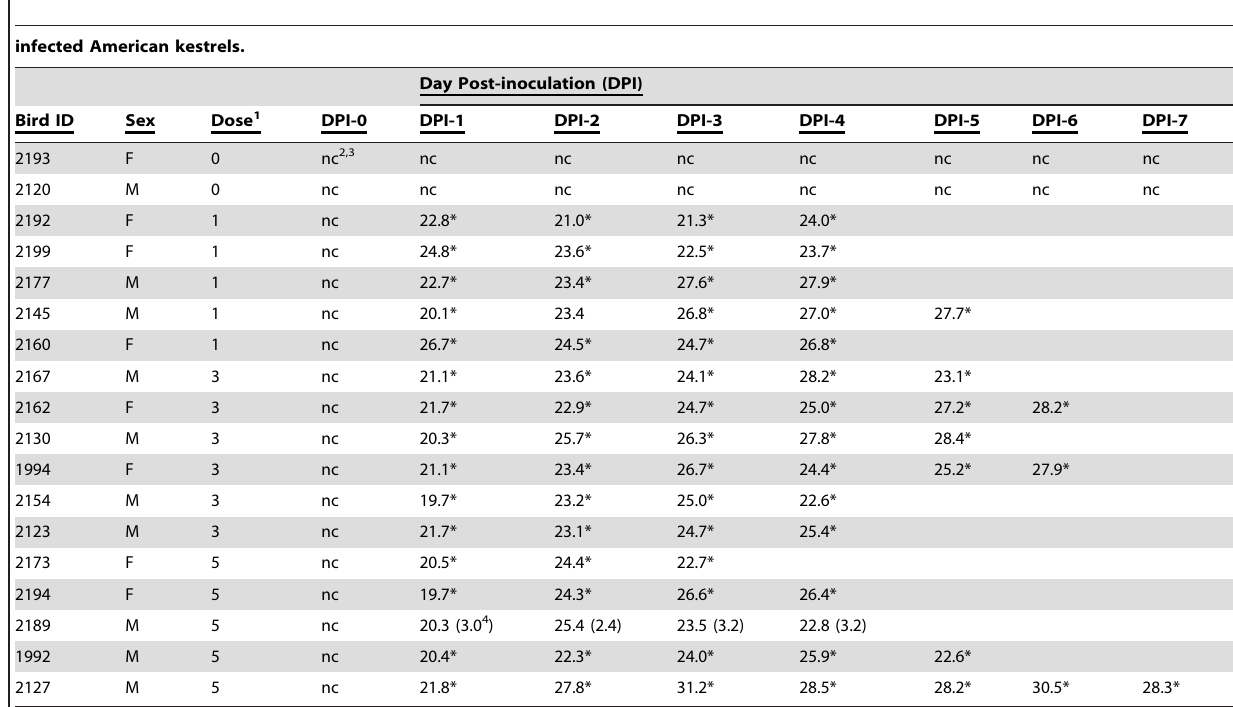
Table 1. Oral shedding of highly pathogenic avian influenza virus H5N1 by experimentally.